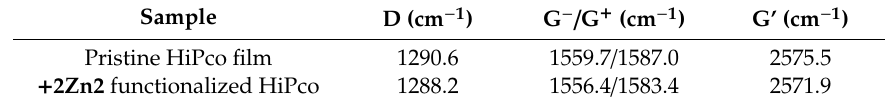
Table 3. Raman Shift data for both pristine and + 2Zn2 hydrazone-functionalized HiPco SWCNTs.